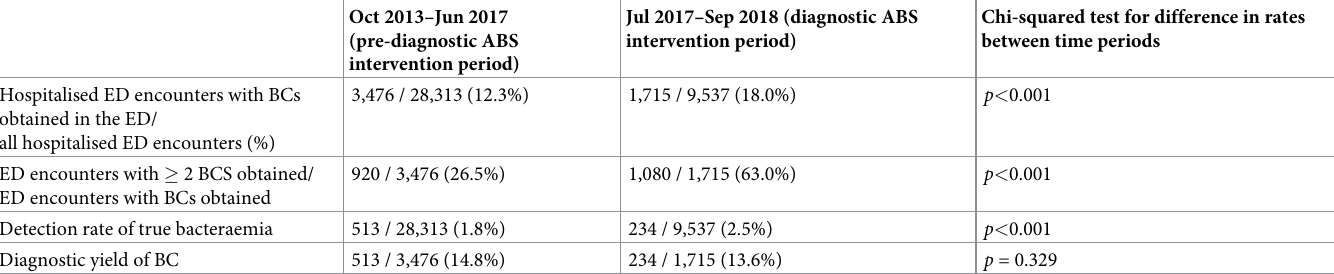
Table 2. BC performance pre- and post-implementation of a diagnostic stewardship strategy in the ED.